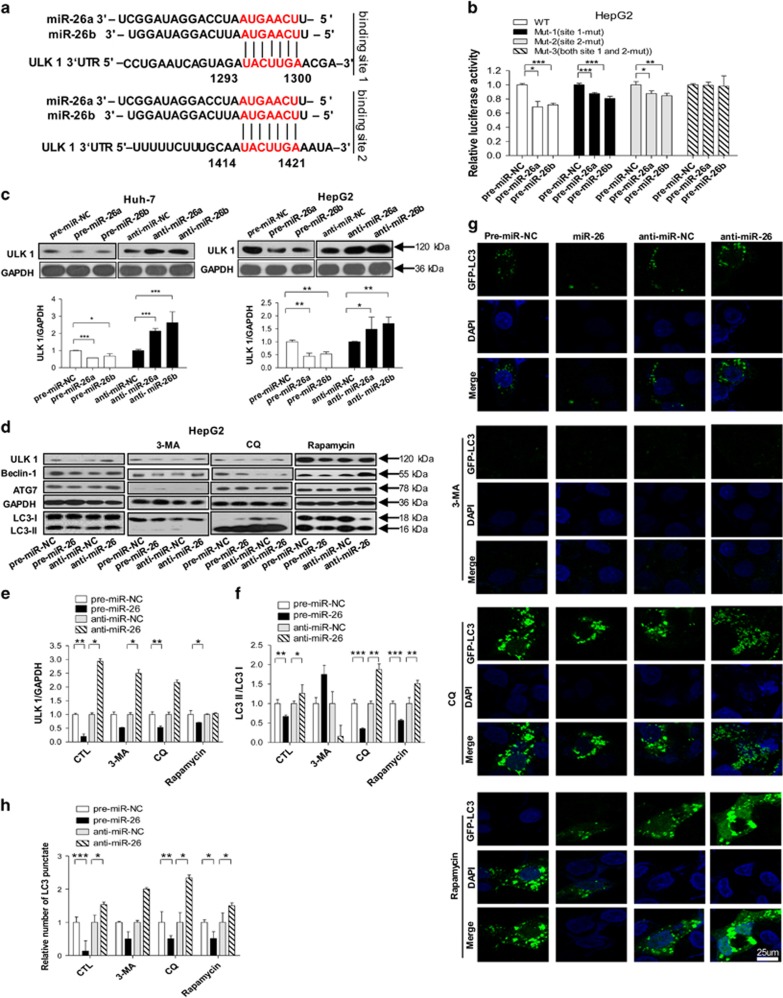
MiR-26a/b directly targets ULK1 and inhibits autophagy at the initial stage in HCC cells. (a) A schematic diagram of ULK1 3′-UTR as a putative target for miR-26a/b. The seed-recognizing sites in the ULK1 3′-UTR by miR-26a/b are indicated in red. (b) Relative luciferase activity in 293T that were transfected with firefly luciferase reporters containing WT or mutant 3′-UTRs of ULK1, pre-miR-26a/b or random pre-miR-NC. (c) Huh-7 and HepG2 cells were transfected with pre-miR-NC, pre-miR-26a/b or anti-miR-NC, anti-miR-26a/b. The ULK1 expression level were detected using immunoblotting. (d) HepG2 cells were transfected with pre-miR-NC, pre-miR-26 or anti-miR-26 for 24 h, cells were treated with/without 3-MA, CQ or rapamycin for 24 h. The expression levels of LC3, ULK1, Beclin-1 and ATG7 were detected. (e) Quantitative analysis of ULK1 protein levels. (f) Quantitative analysis of LC3-II/LC3-I protein levels. (g) HepG2 cells were transfected with GFP-LC3 plasmid, pre-miRNA-NC, miR-26a/b mimics, anti-miR-NC or anti-miR-26; after 24-h transfection, cells were treated with 3-MA, CQ or rapamycin for a further 24 h before observation to count GFP-LC3 puncta under confocal microscopy. Blue indicates DAPI-stained nuclei. Green indicates GFP-LC3. One of 10 representative micrographs is shown. (h) The relative number of GFP-LC3 punctae in cells treated with 3-MA, CQ or rapamycin was calculated from 10 random fields. The data are presented as the means±S.E. obtained from three independent experiments. *P<0.05; **P<0.01; and ***P<0.001